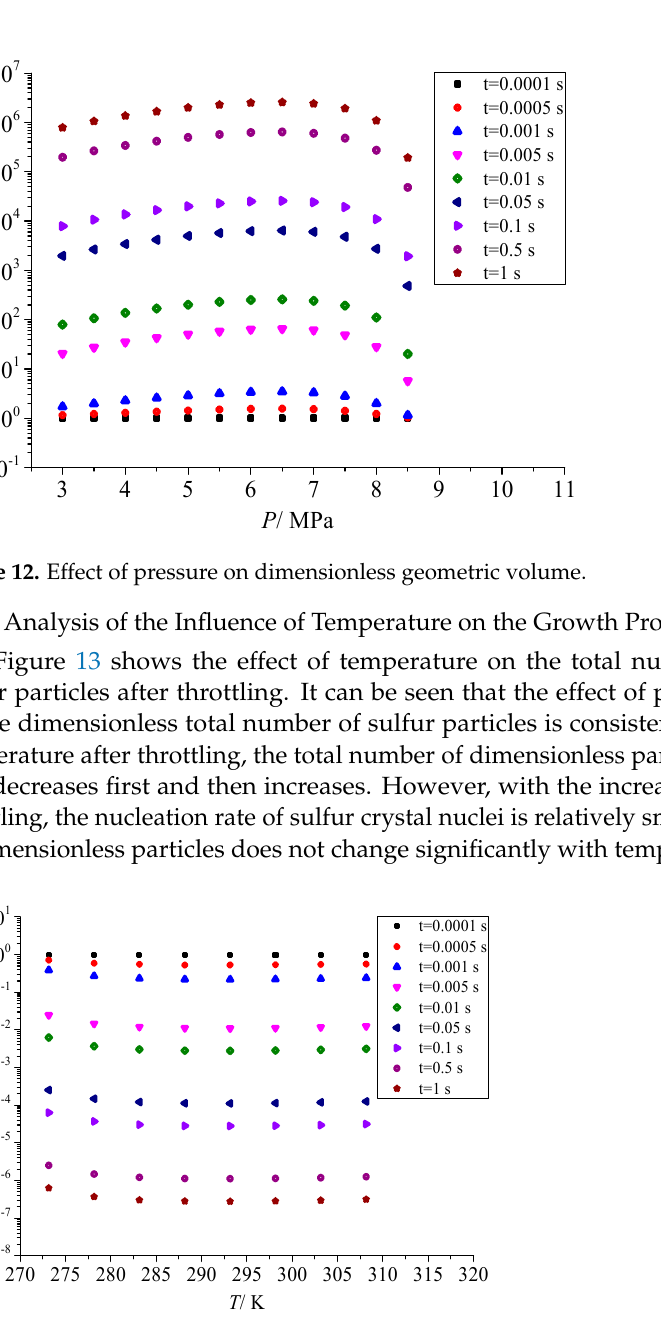
Figure 11. Effect of pressure on geometric standard deviation.